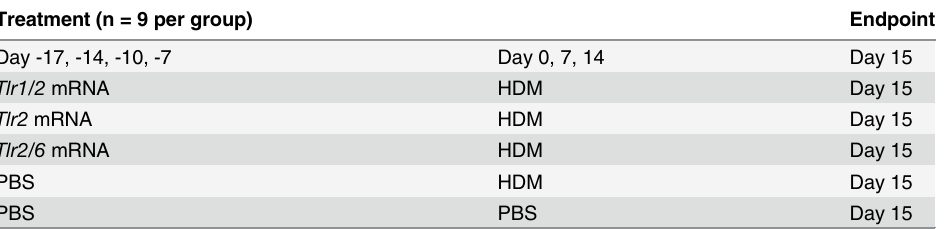
Table 1. Groups of mice and their respective treatment following the injection schedule of Fig 1A. Treatment (n = 9 per group) Endpoint Day -17, -14, -10, -7 Day 0, 7, 14 Day 15 Tlr1/2 mRNA HDM Day 15 Tlr2 mRNA HDM Day 15 Tlr2/6 mRNA HDM Day 15 PBS HDM Day 15 PBS PBS Day 15 Mice were treated intratracheally with combinations of Tlr mRNA at day -17,-14, -10 and -7 prior to the fi rst sensitization with House dust mite extract (HDM), indicated as day 0. Further intratracheal injections with HDM followed on day 7 and 14. On day 15, the predetermined endpoint of the study, mice were sacri fi ced and several readouts were performed. From each group n = 3 mice were subjected to BALF and FACS analysis, while IPL was performed on the remaining n = 6